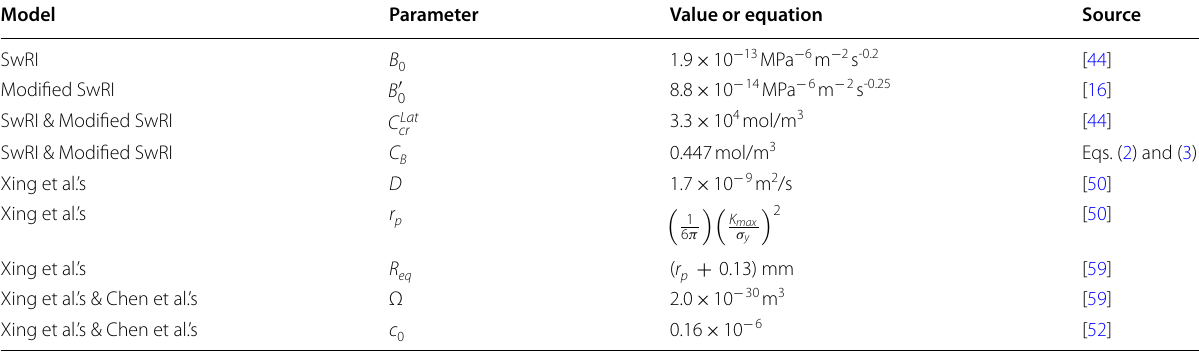
1 The value of C B is calculated using Eqs. (2) and (3) by assuming pH = 7 and φ = − 0.7V